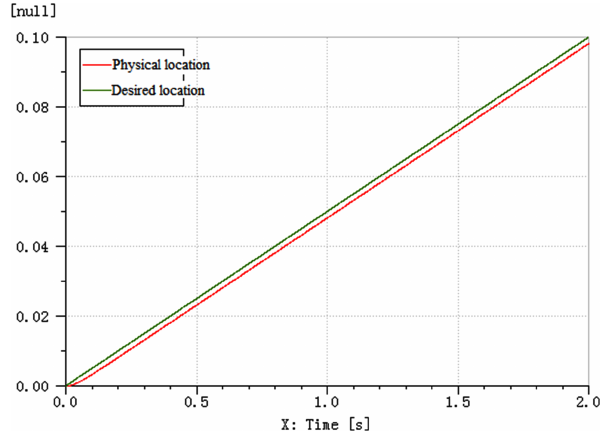
Figure 8. Curves of slope response decoupling.